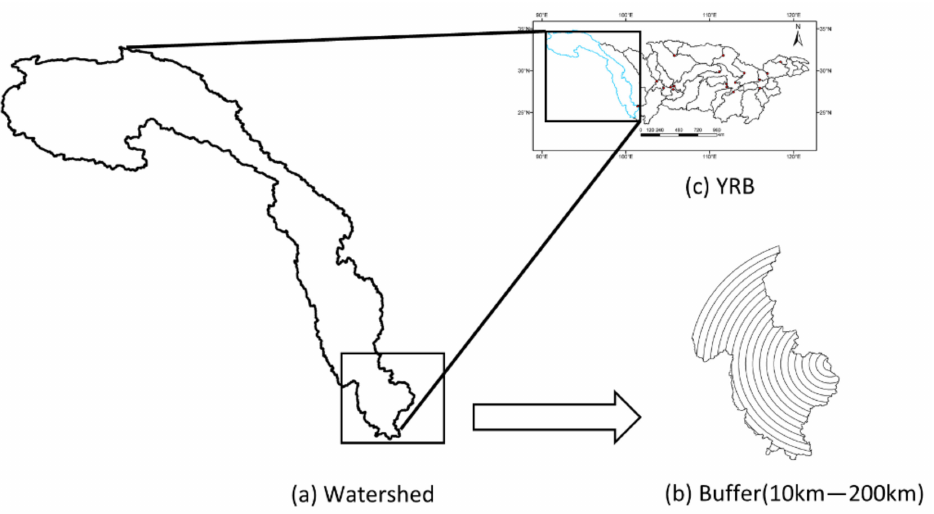
Figure 2. Diagram of watershed ( a ) division and buffer zone ( b ) division in the Yangtze River basin ( c ) (taking Longdong Station as an